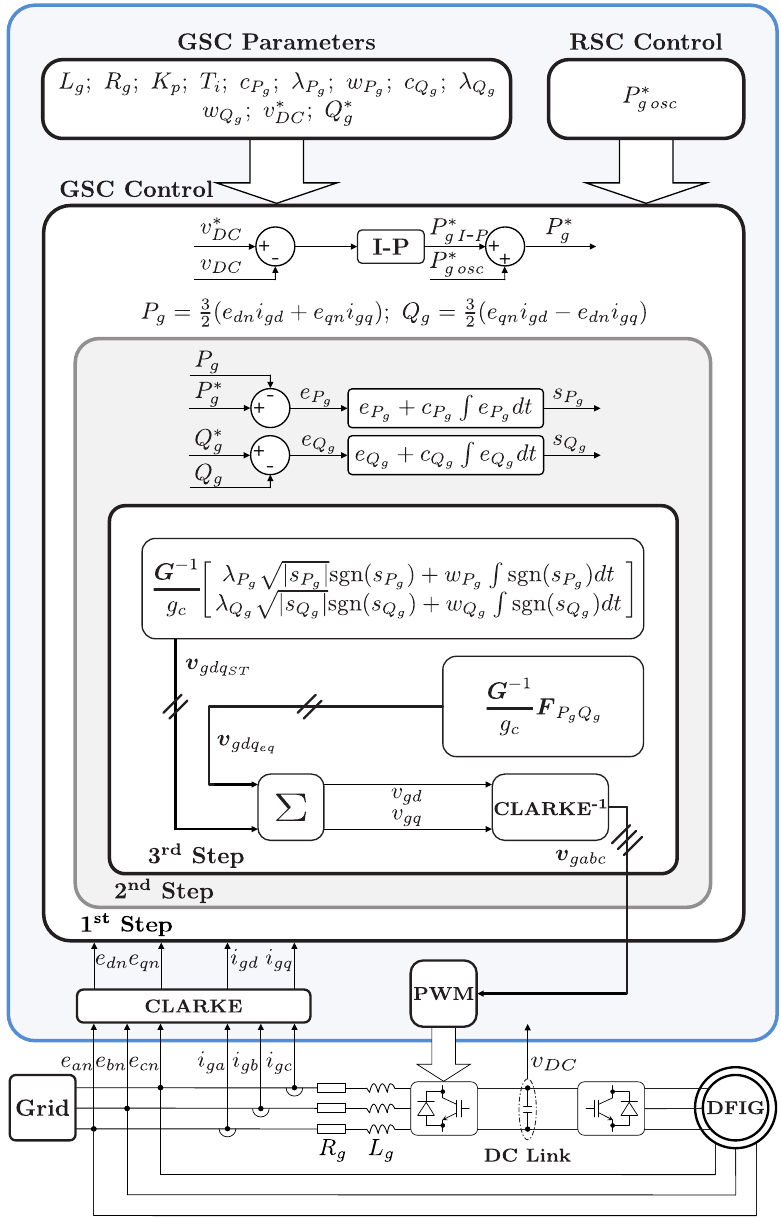
Figure 2. Functional diagram of the control scheme adopted for a DFIG grid-side converter